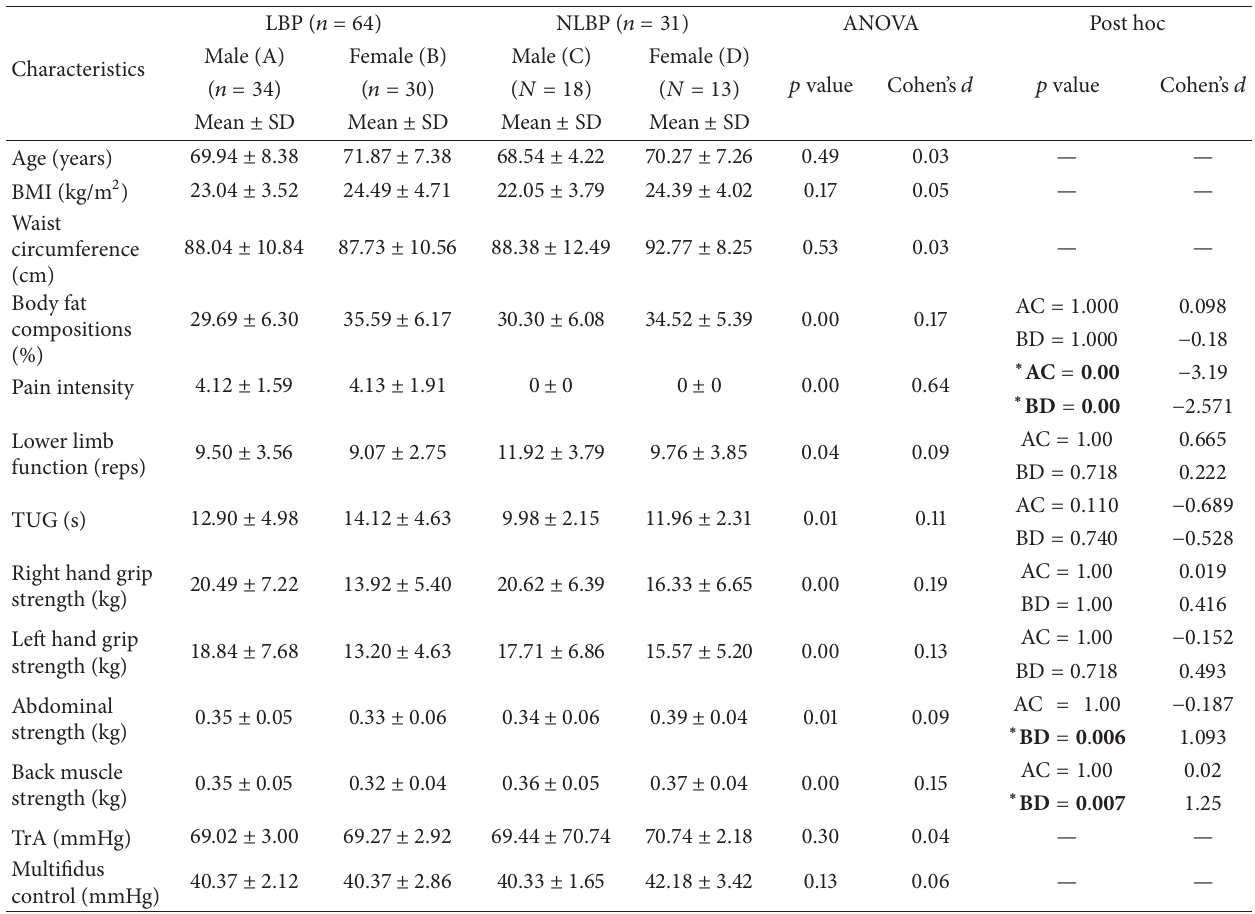
Table 1: Demographic characteristics, pain intensity, functional performances, and muscle functions of the subjects ( 𝑛 = 95 ).